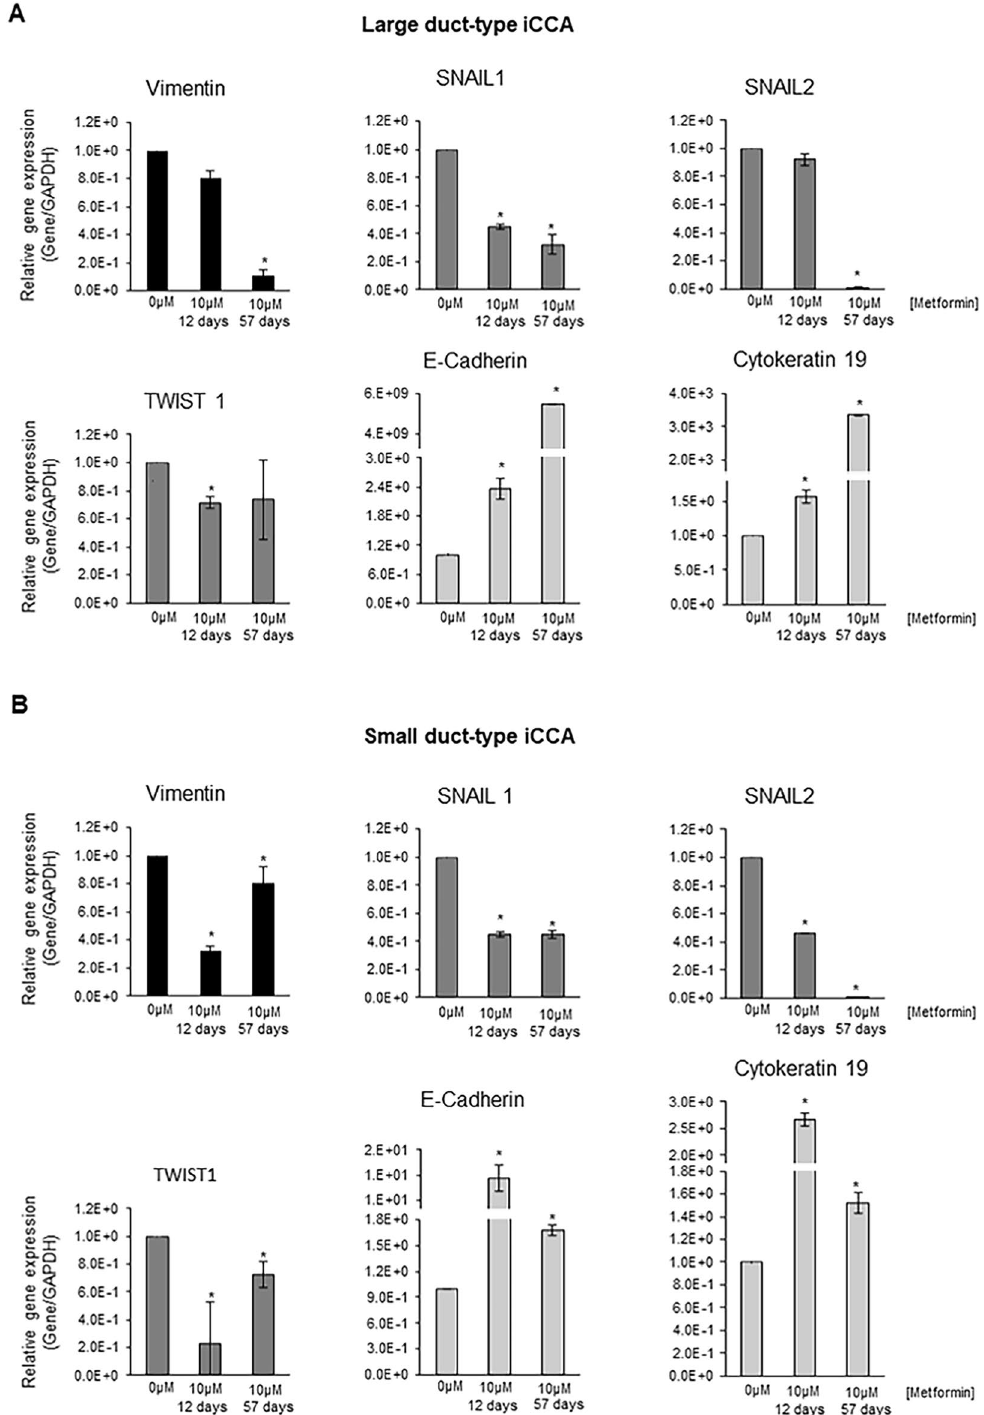
Figure 5. Effect of prolonged treatment (12 and 57 days) of iCCA primary cells with Metformin on the gene expression of mesenchymal, EMT and epithelial markers. The gene expression of mesenchymal and EMT markers (Vimentin, SNAIL1, SNAIL2, TWIST1) and epithelial markers (E-Cadherin, Cytokeratin-19) was analysed by RT-qPCR in Large duct-type iCCA ( A ) and Small duct-type iCCA ( B ) primary cultures exposed to Metformin 10 µM for 12 or 57 days and normalized to the expression of GAPDH (housekeeping gene). The mesenchymal and EMT markers, Vimentin, SNAIL1, SNAIL2 and TWIST1, were markedly down-regulated with respect to controls; in some case almost completely suppressed (i.e. Vimentin and SNAIL2 in Large duct- type iCCA and SNAIL2 in Small duct-type iCCA). The epithelial markers, E-Cadherin and Cytokeratin-19 were markedly upregulated in both Large and Small duct-type iCCA. Data represent mean ± SD of N = 5 independent experiments; * p < 0.05 versus